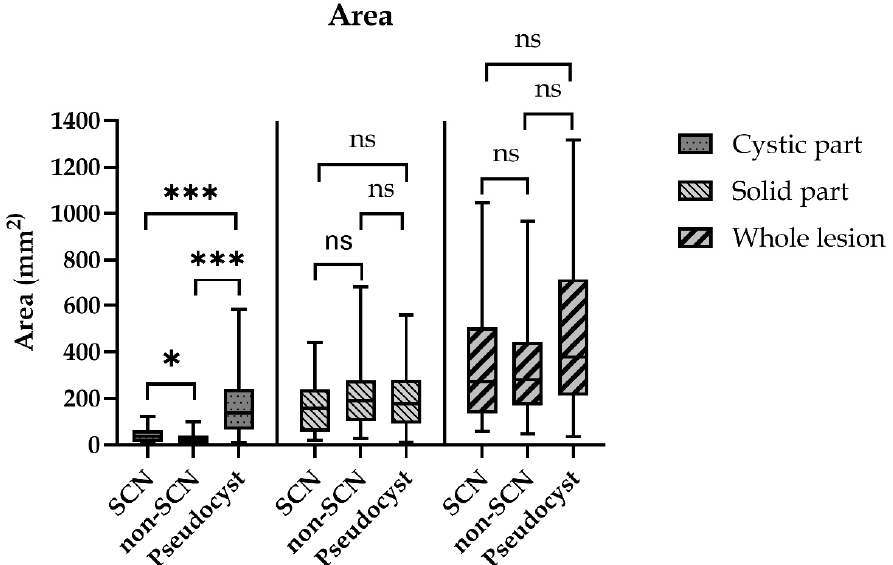
Figure 3. Areas of the different parts of the cystic lesions. Area values were calculated by the software based on the selected areas. (ns = non-significant; * p < 0.05; *** p < 0.0005). The mean number of cystic lobules of the lesions was 2.1 in the SCN group, 2.4 in the Non-SCN and 1.2 in the Pseudocyst groups. There was no significant difference between the SCN and the Non-SCN groups, but in the Pseudocyst group the lesions had signifi- cantly fewer cystic parts, compared to both of the other groups ( p < 0.0005) The mean value of the area ratio, which meant the proportion of the cystic part to the whole lesion was 57%, 39% and 61%, respectively, in the SCN, Non-SCN and the Pseudocyst groups. There was no significant difference between the SCN and Pseudocysts groups, but the Non-SCN group’s area ratio was significantly lower than the SCN and Pseudocyst groups ( p < 0.0005). The mean gray value of the whole lesions was 18.8 ± 1.2, 27.8 ± 0.9 and 19.8 ± 0.9, respectively, in the SCN, Non-SCN and Pseudocyst groups. The mean gray value in the Non-SCN group was significantly higher ( p < 0.0005) compared to both of the other groups. There was no significant difference between the SCN and the Pseudocyst groups. The mean gray value of the cystic parts was 9.7 ± 0.7, 11.1 ± 0.4 and 7.5 ± 0.7, respectively, in the SCN, Non-SCN and Pseudocyst groups. In the Pseudocyst group, the mean gray value of the cystic parts was significantly lower than in the Non-SCN ( p < 0.0005) and in the SCN ( p = 0.007) groups. The mean gray value of the solid parts (intracystic septa, mural nodules, cystic walls) was higher in the Non-SCN (39.0 ± 1.2) and in the Pseudocyst (40.7 ± 1.6) groups than in the SCN group (31.4 ± 1.2). There was no significant difference be- tween the Non-SCN and Pseudocyst groups, but in the SCN group, the cystic mean gray value was significantly lower compared to the Non-SCN ( p = 0.0009) and the Pseudocyst ( p < 0.0017) groups (Figures 3 and 4).